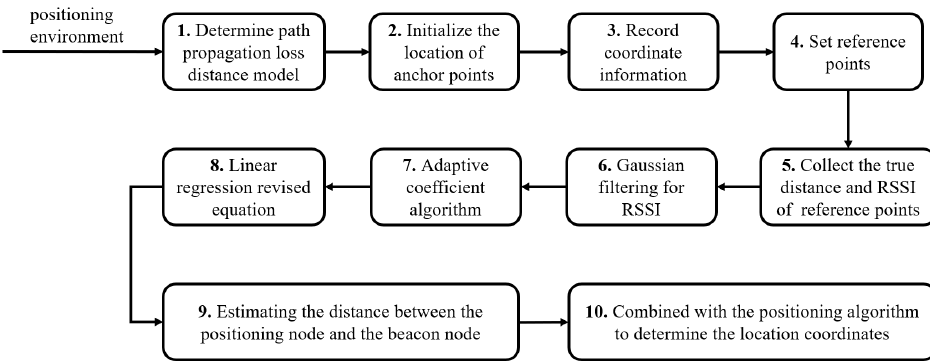
Figure 1. The localization process of indoor